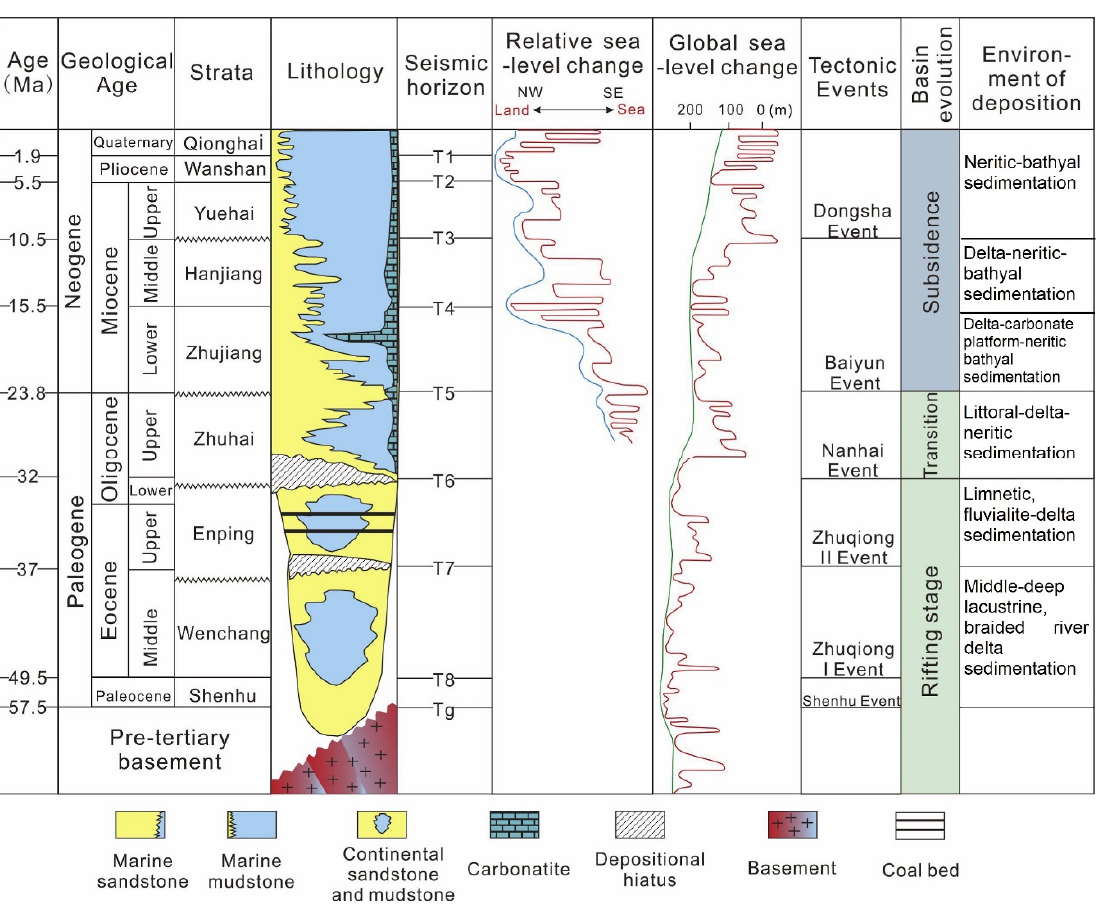
Figure 2. Structural evolution characteristics and stratigraphic column of the PRMB, modified from